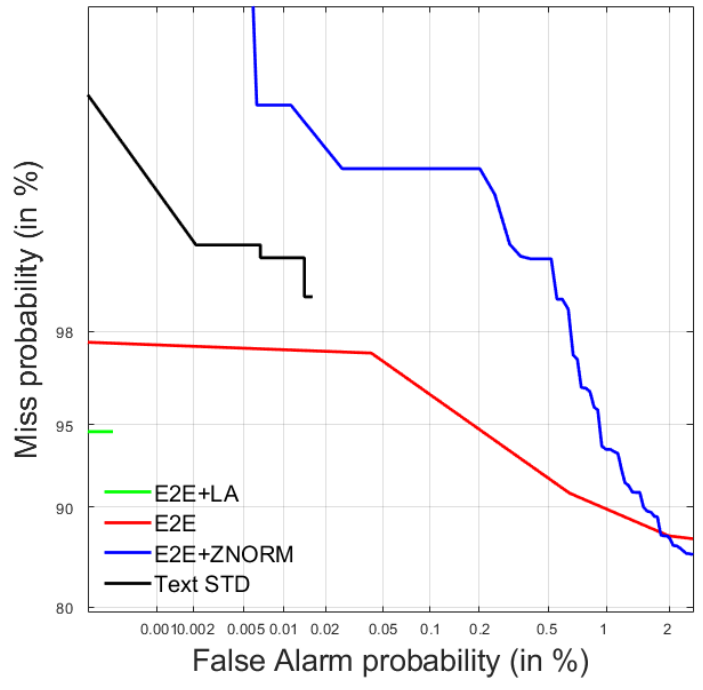
Figure 8. DET curves of the QbE STD systems and the text-based STD system for MAVIR develop- ment data.